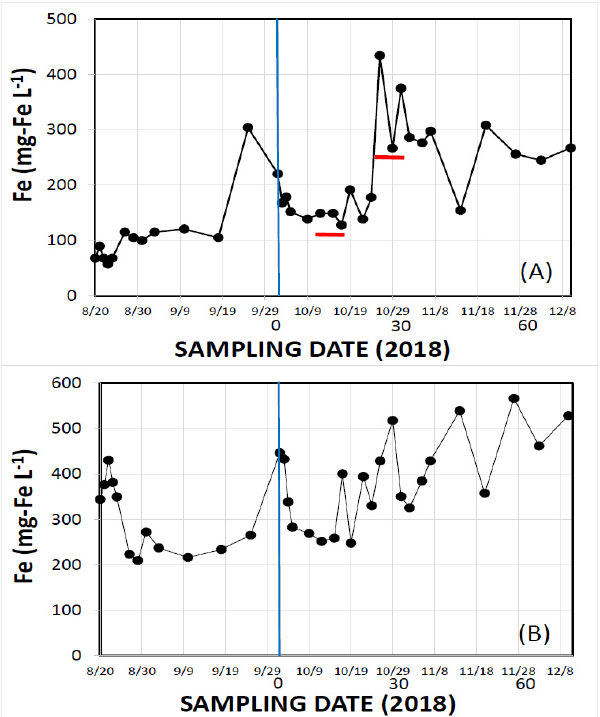
Figure 2. Changes in the concentrations of iron fine particles retained on GF/F filter (>0.7 µ m) during the experiments. Blue vertical lines show the day when bubbling with microbubbles was initiated (1 October). ( A ): in the emulsion-type cutting fluid (E-CF). Two horizontal red bars show the period when bubbling with microbubbles was stopped; ( B ): in the soluble-type cutting fluid (S-CF). Num- bers of 0, 30, and 60 below the date in each figure show the days after starting to supply microbub- bles.